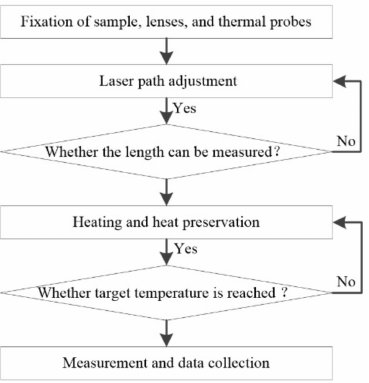
Figure 3. Flowchart of the steps for coe ffi cient of thermal expansion (CTE)